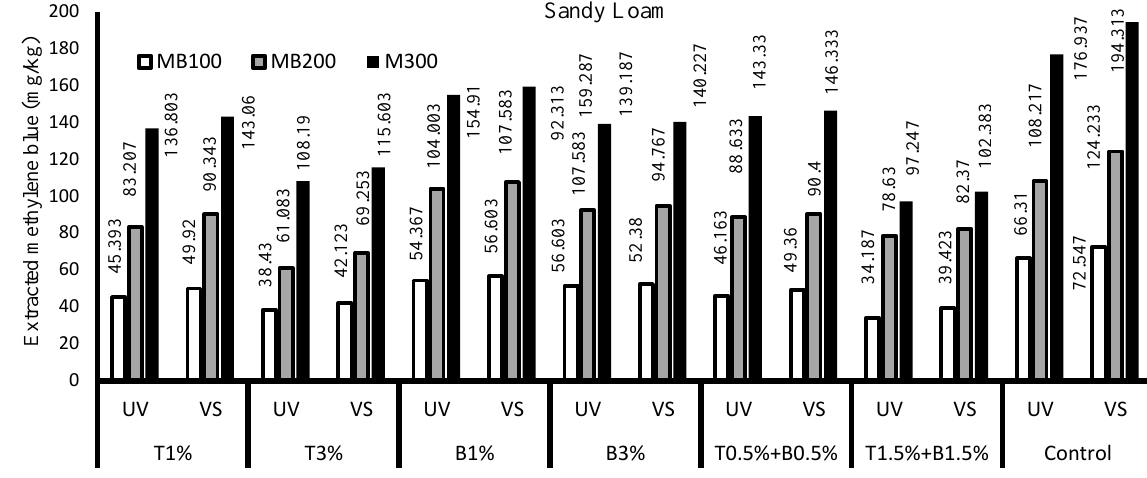
Fig. 7. Effects of amendment treatments and radiation sources on extracted MB from SL and L soils (each column with mean of nine samples; different letters indicate significant differences in means of different treatments;